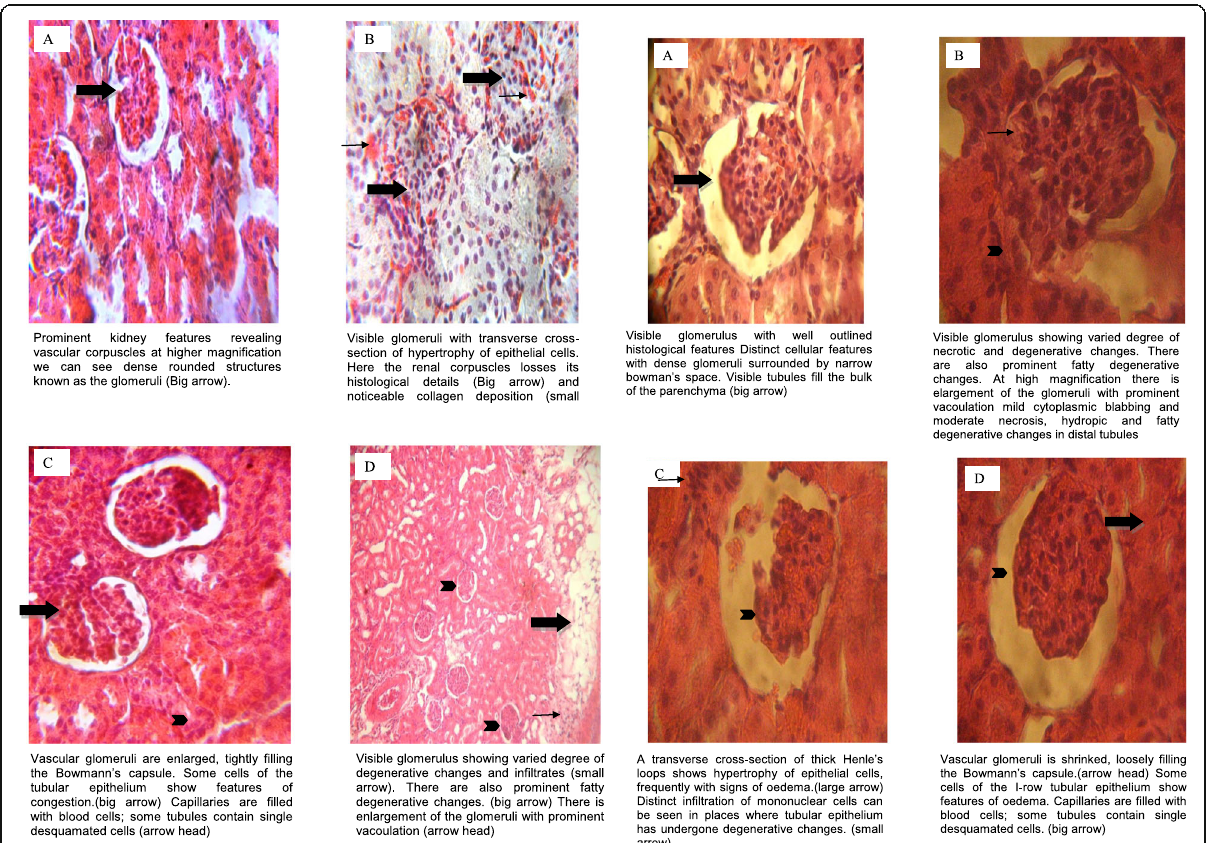
Fig. 2 a Morphological changes in the kidney of rats exposed to contaminated diet after 1-month exposure. (A) Control. (B) Cd-contaminated diet. (C) As-contaminated diet. (D) Cd + As-contaminated diet. b Morphological changes in the kidney of rats exposed to contaminated diet after 3-month exposure. (A) Control. (B) Cd-contaminated diet. (C) As-contaminated diet. (D) Cd + As-contaminated